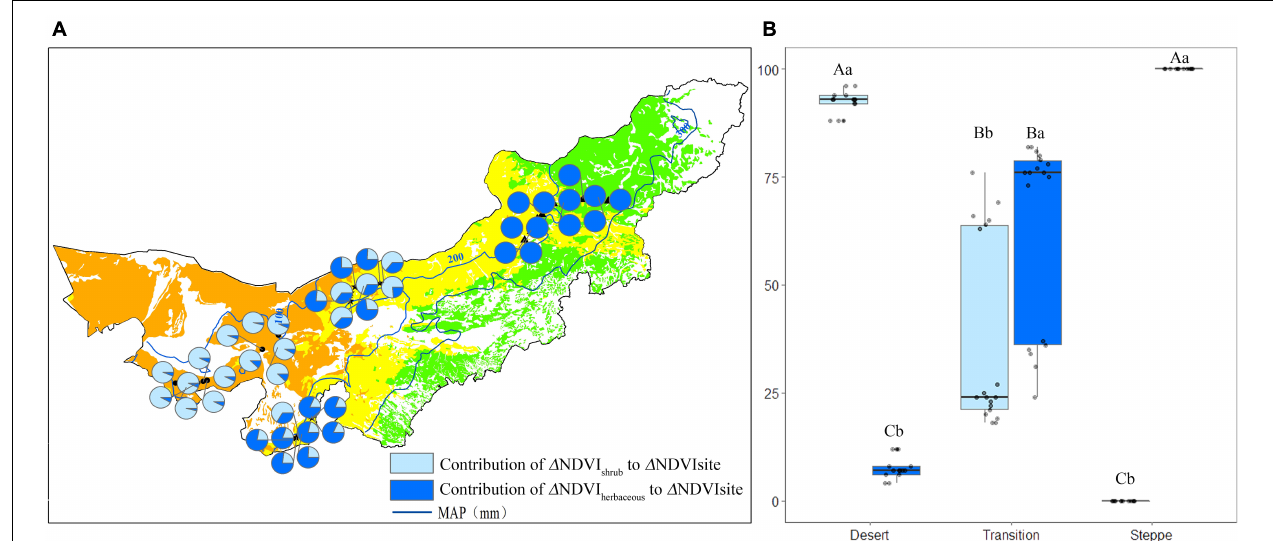
FIGURE 6 | The contribution (%) of shrub/herbaceous NDVI changes to the site NDVI changes in each observation site (A) , and statistics for desert, transition zone, typical steppe (B) . Different capital letters denoted significant differences of the contribution of shrub/herbaceous NDVI changes to the site NDVI changes among desert, transition zone, and typical steppe ( P < 0.05); while different lowercase letters denoted significant differences between shrub and herbaceous ( P < 0.05); the same letters denoted non-significant differences ( P > 0.05); MAP represents the mean annual precipitation.